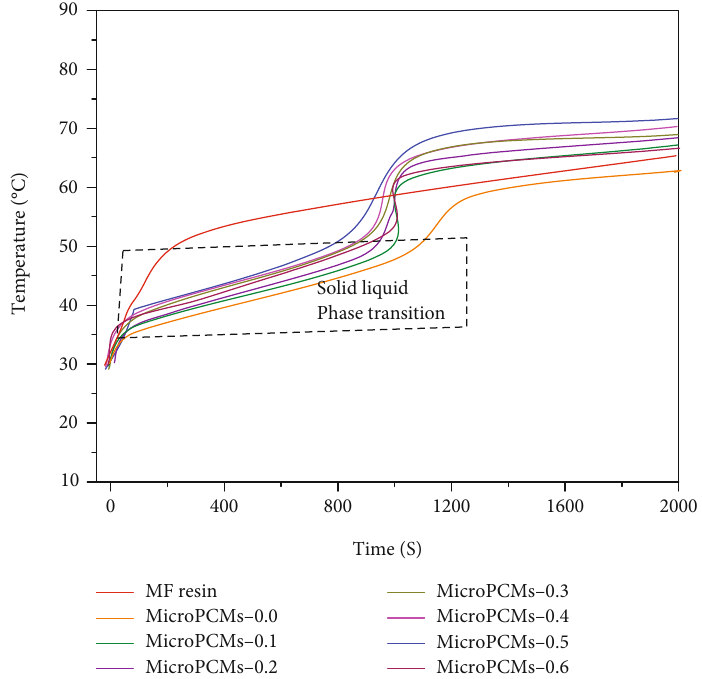
Figure 4: Irradiation time a ff ects both the MF resin and microPCMs ’ temperature